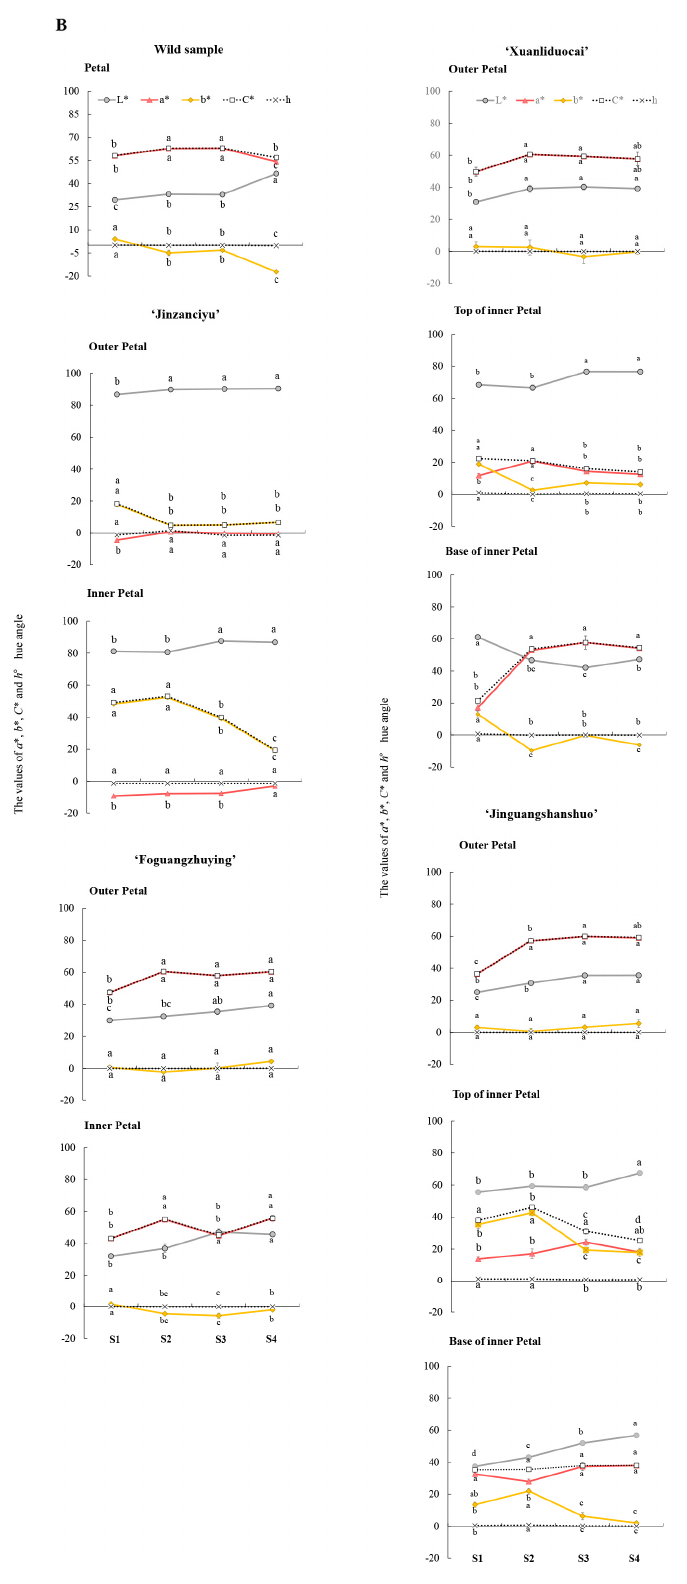
Figure 1. Changes of petals colorimetric results ( A ) and color values ( B ) in different flowering stages of herbaceous peony. Notes: The data sets of the same variety and the same petal position at different flowering stages were analyzed. Different lowercase letters indicate significant differences at p < 0.05 level. Abbreviations: S1, bud stage; S2, opening stage; S3, blooming stage; S4, decay stage; L* , brightness; a* , red/green value; b* , yellow/blue value; C* = ( a * 2 + b * 2 ) 1/2 , chroma; h ◦ = arctan ( b */ a *), hue angle.